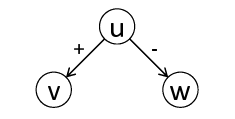
Figure 1: Gene u activates v and inhibits w .